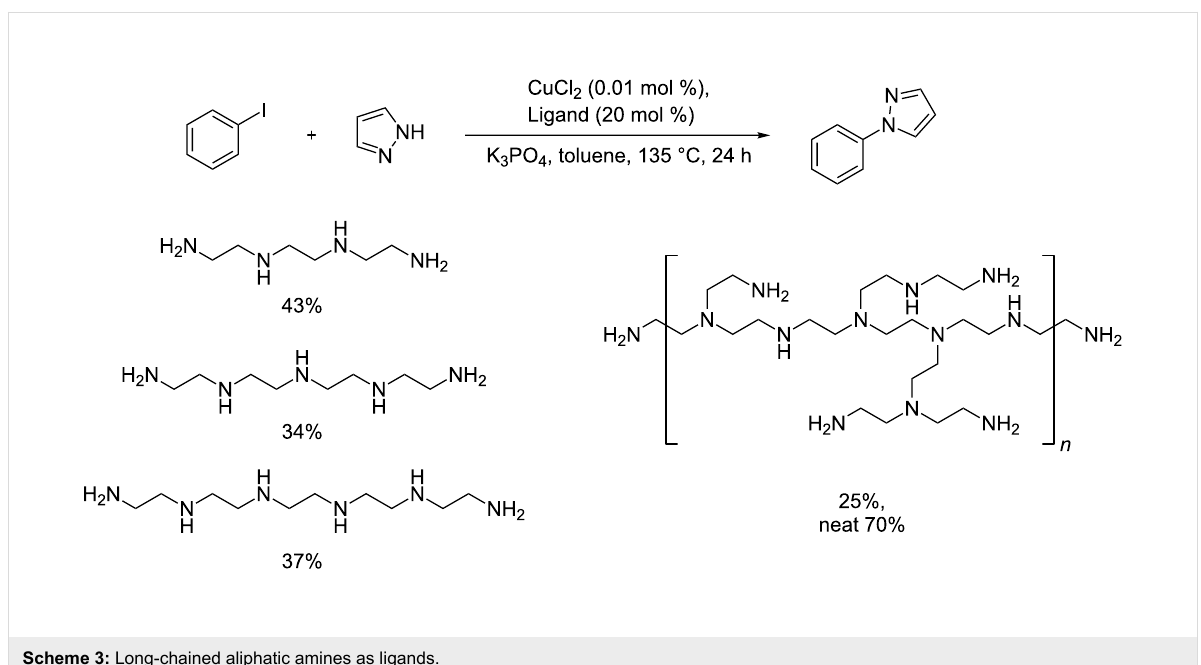
Scheme 3: Long-chained aliphatic amines as ligands.